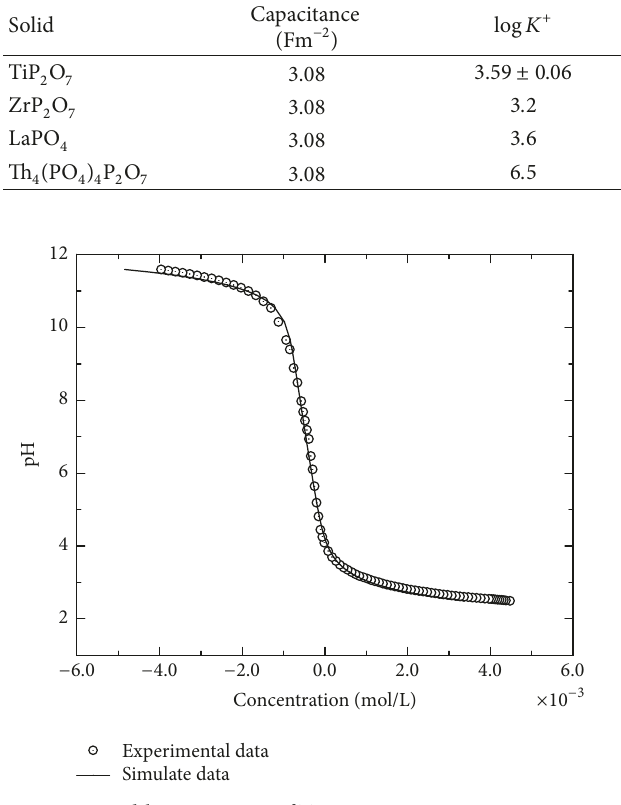
Figure 6: Acid/base titrations of TiP 2 O 7 in 0.5 M potassium nitrate solution. Experimental (circle) and CCM calculated curve (line). Table 2: Equilibrium constants of the chemical species of europium in 0.5 M KNO 3 solution.